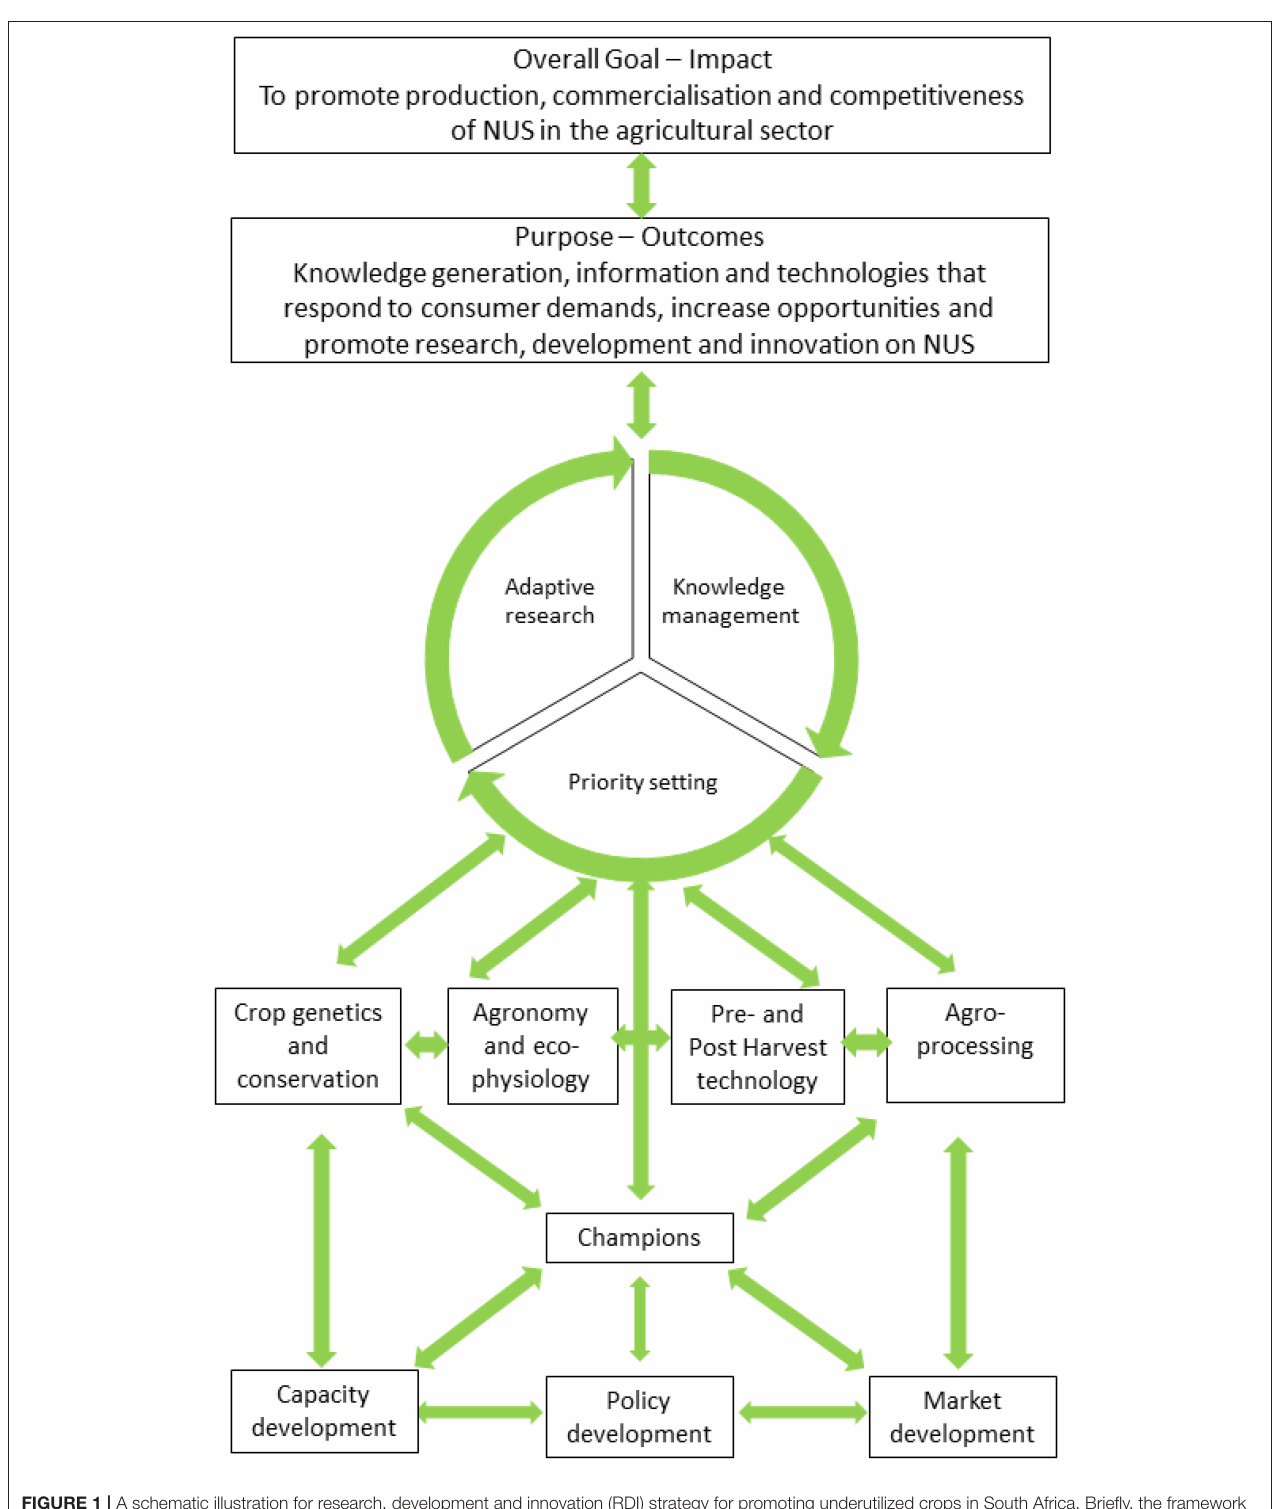
FIGURE 1 | A schematic illustration for research, development and innovation (RDI) strategy for promoting underutilized crops in South Africa. Briefly, the framework promotes continuous priority setting, adaptive management and knowledge management as drivers of RDI along the value chain. The central role of champions in feeding into this RDI and taking outputs forward into human capacity development, policy, and market development is also highlighted.